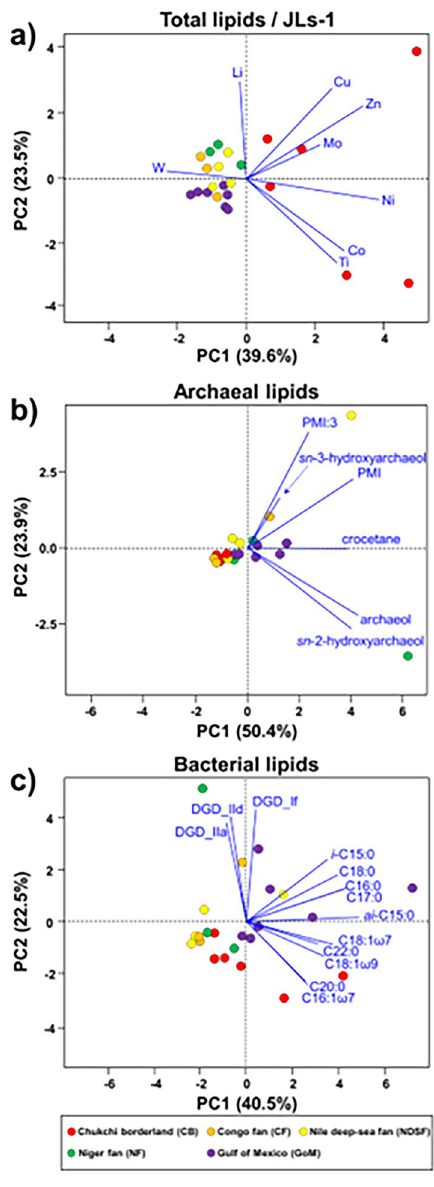
Figure 5. PCA results for ( a ) the trace metal data for the total lipids normalized to the values of the JLs-1 carbonate reference material, and for the concentration data of ( b ) archaeal lipids and ( c ) bacterial